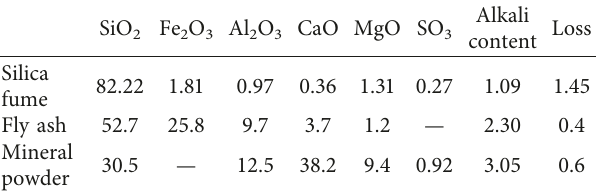
Table 2: The chemical composition of silica fume, class I fly ash, and S95 slag